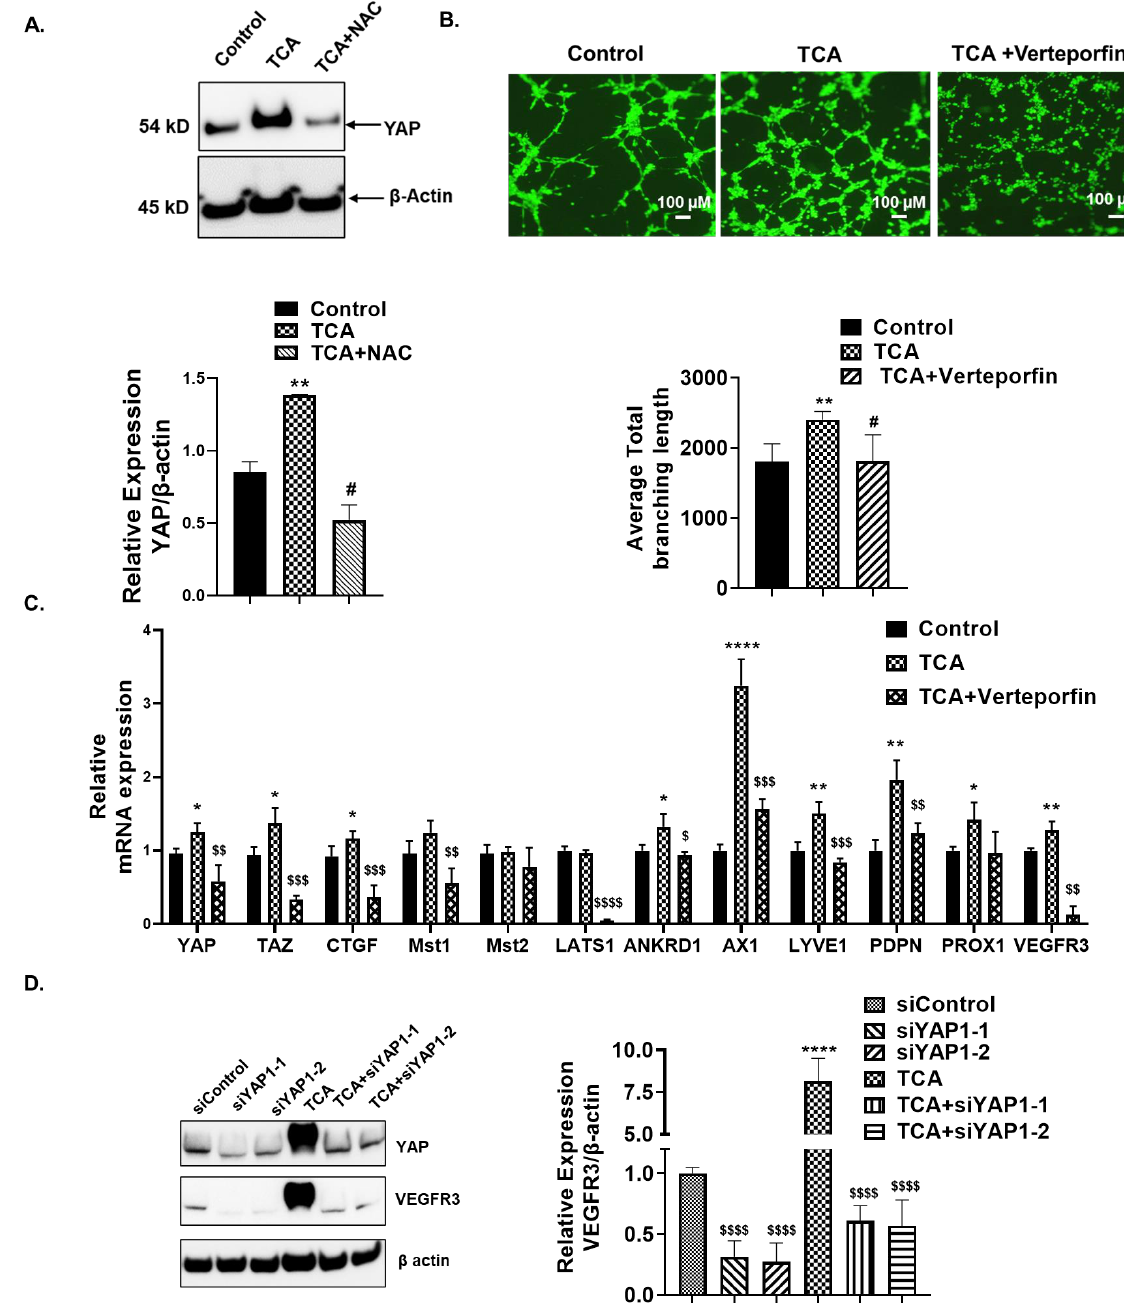
Figure 6. TCA-induced lymphangiogenesis of HLECs via the activation of YAP-VEGFR3 axis. ( A ) TCA (100 µM)-induced YAP expression as determined by Western blot. ( B ) YAP-TEAD inhibitor verteporfin abrogates TCA-induced tube formation in HLECs. Representative 4X images were given. Scale bar = 100 µm. Graphs represent total branching length as measured by ImageJ. Values represent mean ± SD n ≥ 3. Statistical analysis was done by ANOVA followed by Fishers LSD. ** Represents p ≤ 0.01 as compared to control. #, represents p ≤ 0.05 compared to TCA. ( C ) Inhibition